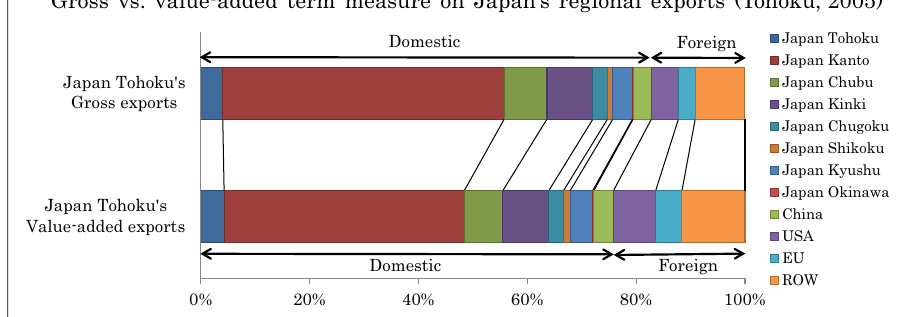
Fig. 4 Gross versus value-added term measure on Japan’s regional exports (Tohoku 2005)